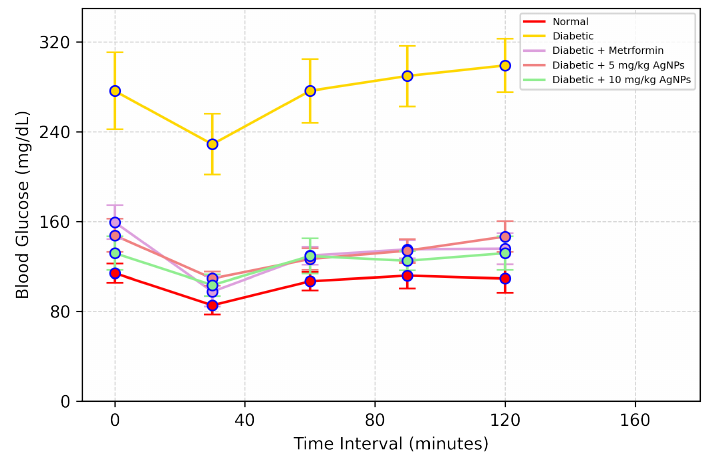
Figure 15. Effect of AgNPs on insulin tolerance (day 31). Results of the healthy, diabetic, metformin- treated and AgNP-treated low (5 mg/kg) and high dose (10 mg/kg) mice post treatment.